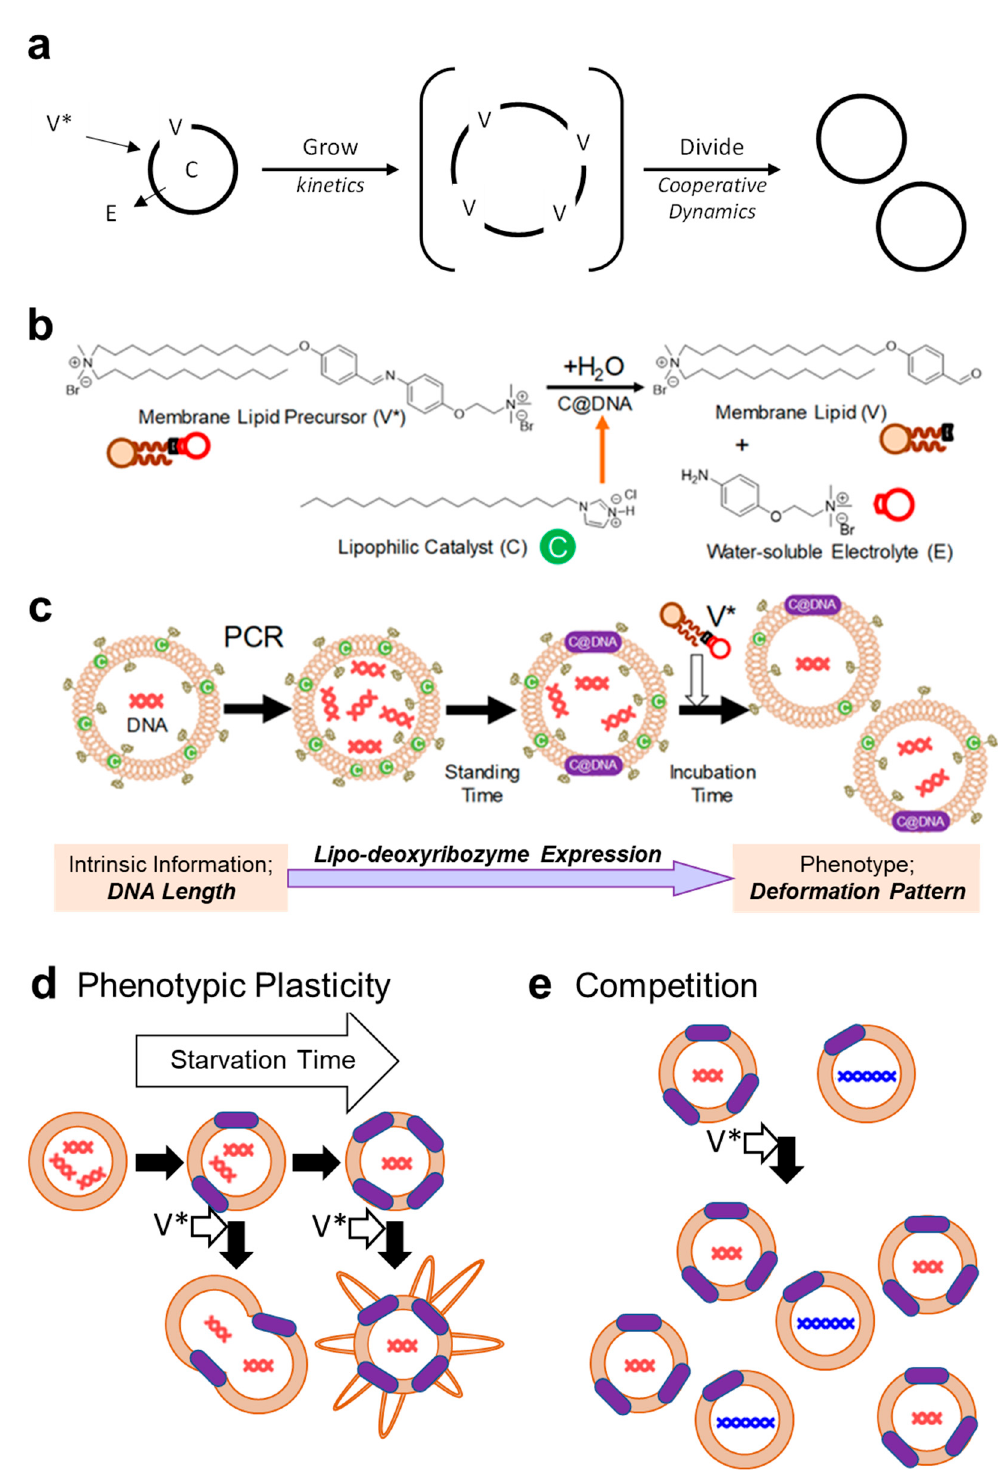
Figure 1. Self-reproduction of GV-based artificial cells working as self-reproducing molecular machines ( a ). Relevant molecular structures. V* is a precursor of membrane lipids (nutrients), V is a membrane lipid, E is a water-soluble electrolyte, and C is an amphiphilic catalyst ( b ). DNA amplification in GV-based artificial cells and the formation of C @DNA and its proliferation induced by the addition of V* ( c ). Artificial cells exhibiting phenotypic plasticity depending on starvation time ( d ). Competitive proliferation between GVs incorporating different DNA lengths. Red double helices represent short DNA and blue double ones represent long DNA ( e ).